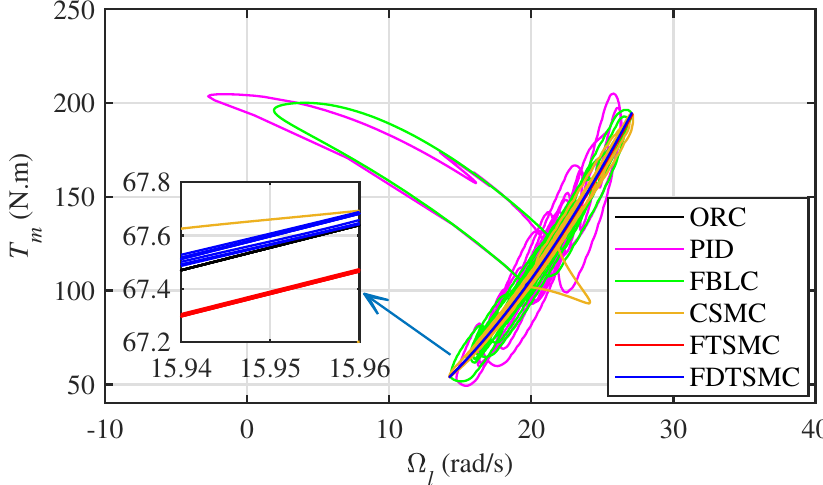
Figure 14. Mechanical torque versus the low-speed shaft rotational